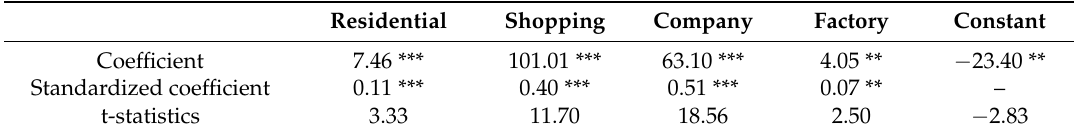
Table 4. Results of the multivariate regression using the four POI density variables (R 2 =